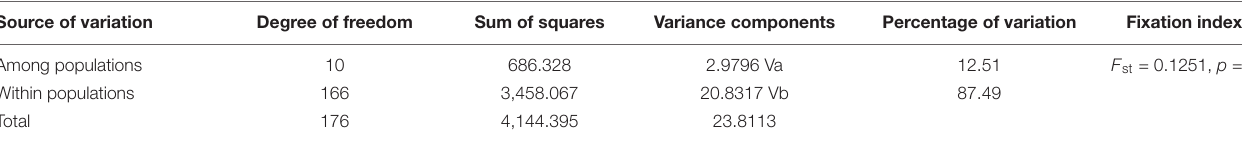
TABLE 4 | Analysis of molecular variance (AMOVA) for the different populations of Aphis aurantii . Source of variation Degree of freedom Sum of squares Variance components Percentage of variation Fixation index Among populations